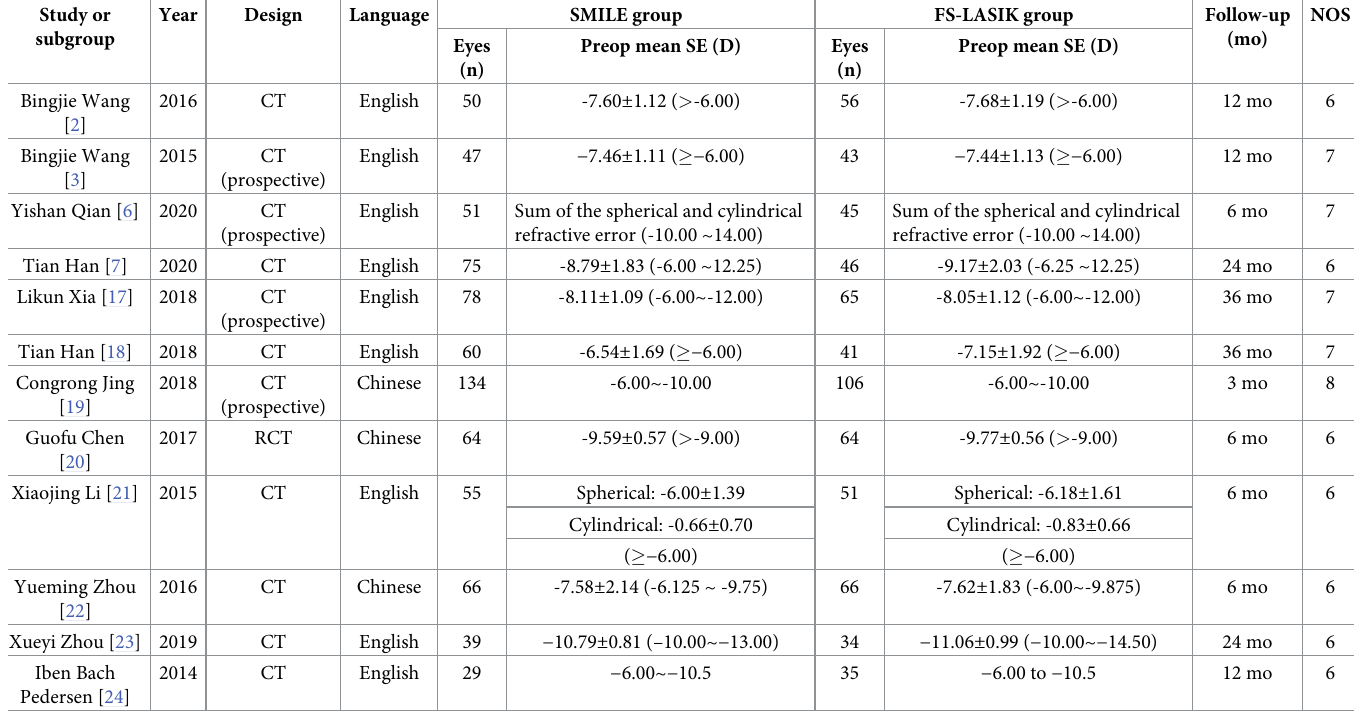
Table 1. Characteristics of the 10 included